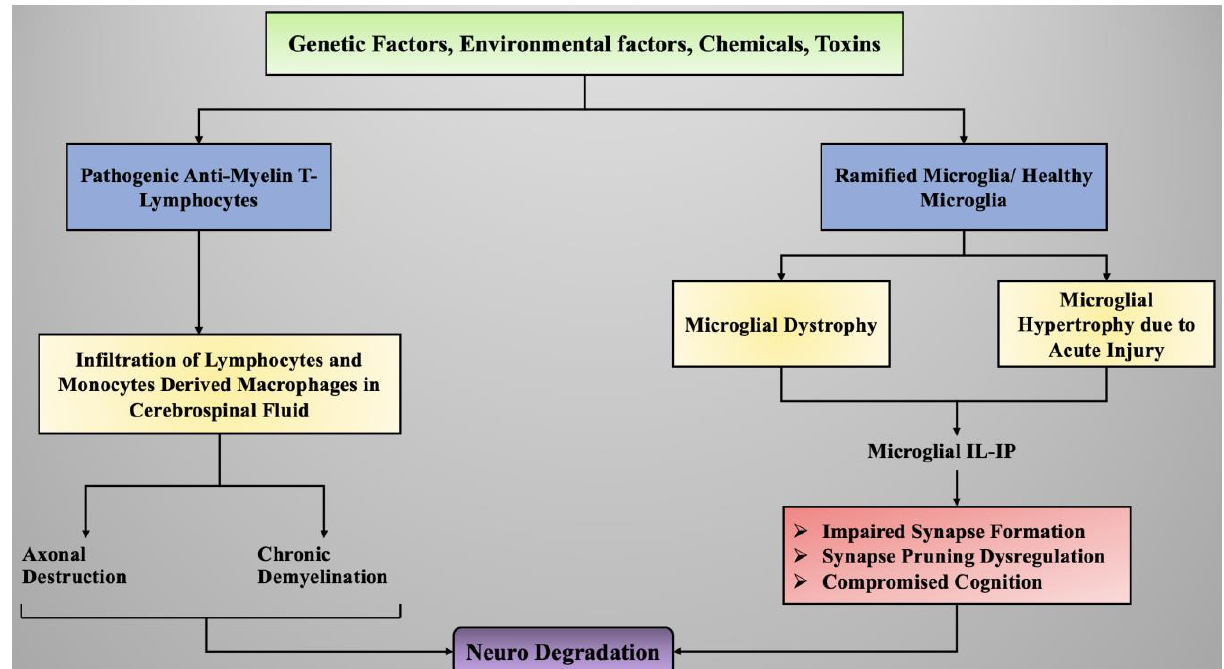
Figure 5. Environmental factors, toxins, chemicals, or genetic factors that can lead to the activation of anti-myelin T-lymphocytes. Legend: IL — interleukin; IP — inducible protein.